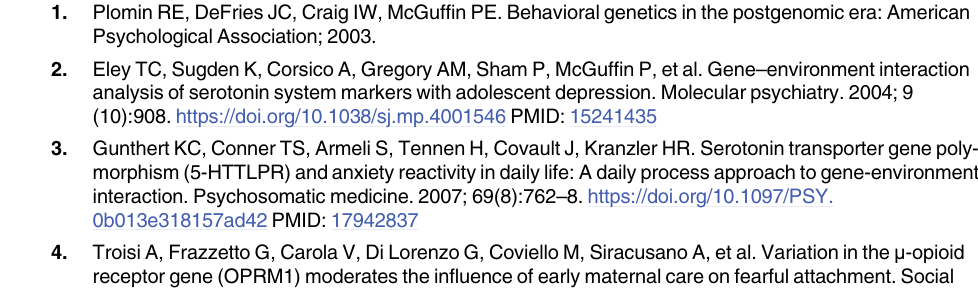
S1 Table. All data underlying the findings. LDAEP, loudness dependence of auditory-evoked potentials; SAI, state anxiety inventory; BDI, Beck depression inventory; CTQ, childhood trauma questionnaire; BIS, behavioral inhibition system; RSQ, rejection sensitivity question- naire; EN, emotional